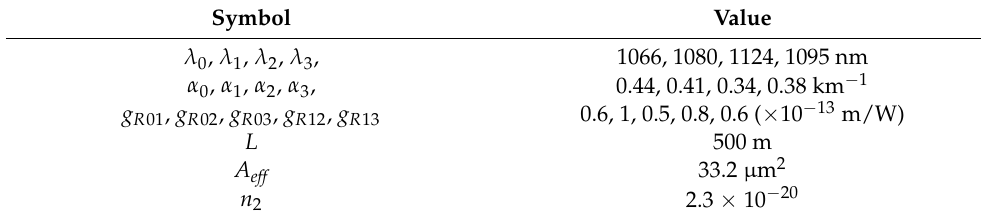
Table 1. Fiber parameters in our numerical calculation.